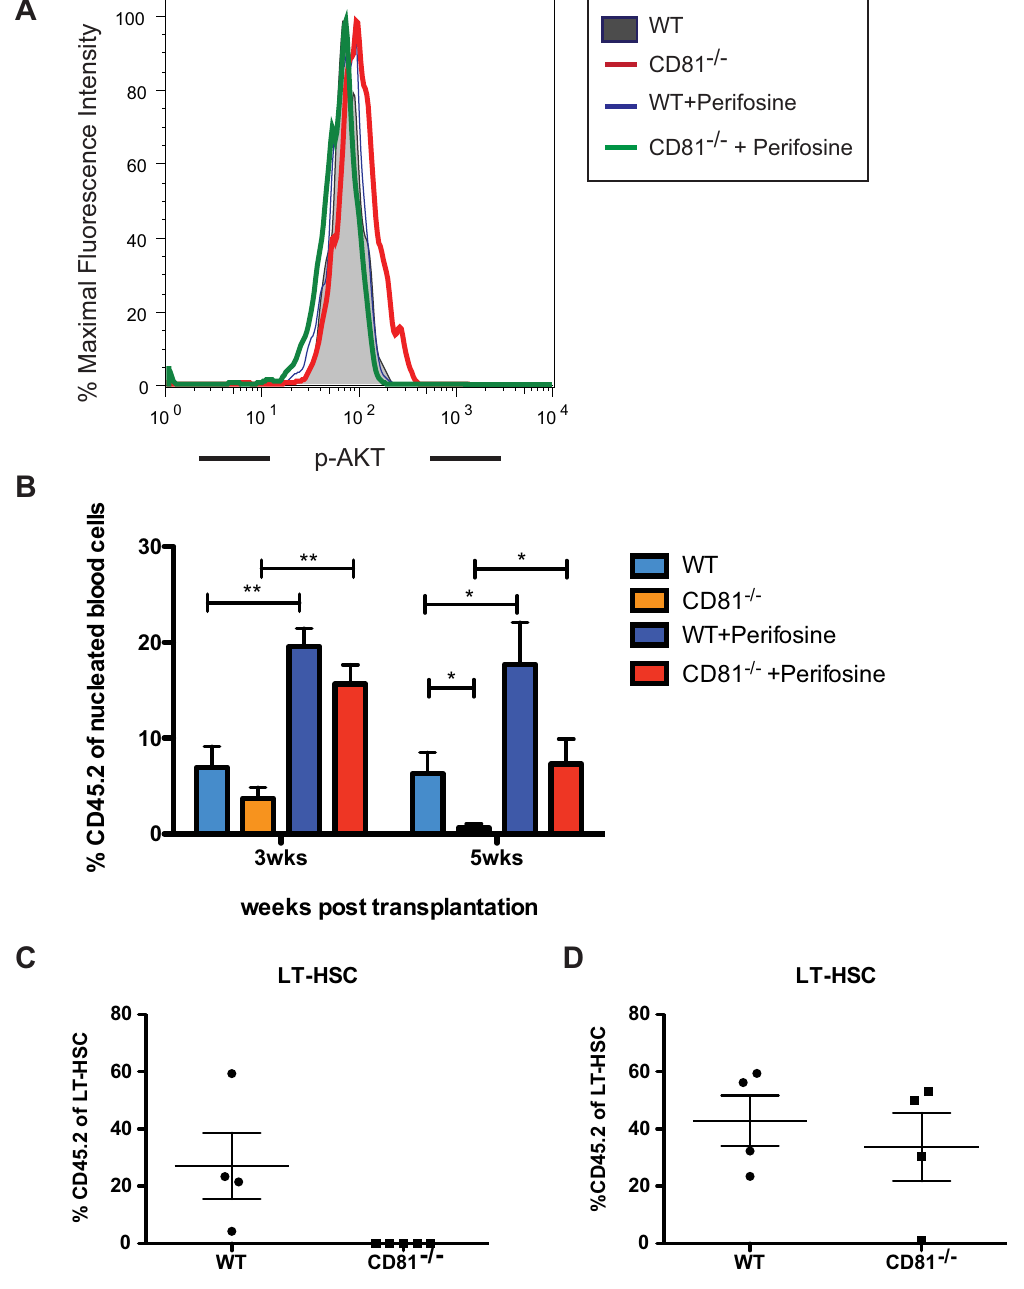
Figure 6. The engraftment defect of Cd81 2 / 2 HSCs in the secondary transplantation can be rescued by perifosine. (A) Cd81 2 / 2 HSCs present an elevated phospho-Akt, when comparing to the regenerating WT HSCs at the same time point of 5FU-stimulated regeneration; while the level of phospho-Akt can be suppressed with an in vitro perifosine treatment. Two independent experiments were performed. (B) A single perifosine treatment during the recovery phase of the primary transplantation rescues the secondary engraftment defect of Cd81 2 / 2 HSCs in the peripheral blood compartment. After stable engraftment, 500 donor HSCs (c-Kit + Sca-1 + Lin 2 CD150 + CD48 2 CD45.2 + ) from the primary recipients were transplanted into lethally irradiated recipients (CD45.1) with 3 6 10 5 WBM competitor cells. The perifosine-treated Cd81 2 / 2 HSCs showed viable peripheral blood engraftment at the time when the engraftment of untreated Cd81 2 / 2 marrows starts to diminish. Mean values 6 SD are shown ( n =5 per group of treatment, * p , 0.05, ** p , 0.01). (B) The engraftment defect in the secondary transplantation originates in the HSC compartment. Secondary recipients transplanted with Cd81 2 / 2 HSCs lack donor-derived HSCs. (C) The secondary engraftment defect of Cd81 2 / 2 HSCs are rescued by one dose of perifosine. Perifosine was given to the primary recipients at day 7 after the initial transplantation. Ten weeks later, to allow HSCs to regenerate after the primary transplantation, HSCs were purified from the primary recipients and 500 of these donor-derived ( Cd81 2 / 2 ) HSCs were transplanted along with 3 6 10 5 competitor cells into lethally irradiated recipients. Twenty weeks later, the donor HSC-derived progeny in these secondary recipients were examined. Mean percentages 6 SD are shown (* p , 0.05, n =4 in the wild type control, n =5 in the Cd81 2 / 2 group, n =4 in the wild type treated with perifosine, n =4 in the Cd81 2 / 2 treated with perifosine). Figure 5B shows the groups with no perifosine treatment